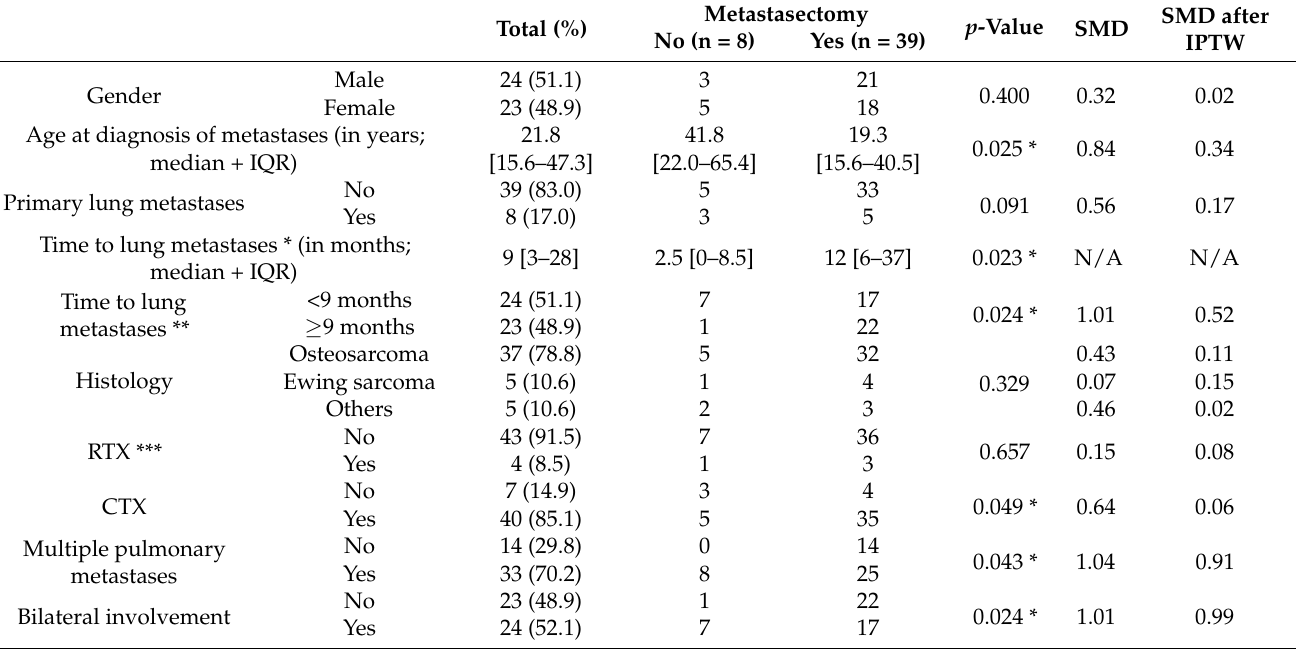
Table 1. Differences at baseline between patients with and without